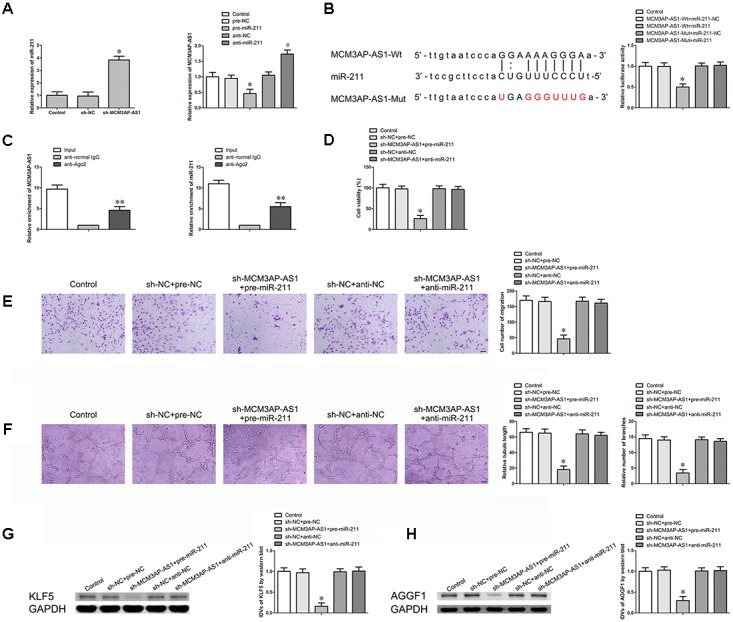
Knockdown of MCM3AP-AS1 inhibited GBM angiogenesis, KLF5 and AGGF1 expression via increasing miR-211 expression. (A) Quantitative real-time PCR analysis for miR-211 expression negatively correlative with MCM3AP-AS1 in GECs. Data are presented as mean ± SD. (n = 5, each group), ∗P < 0.01 vs. sh-NC group, ∗P < 0.01 vs. pre-NC group; #P < 0.01 vs. anti-NC group. (B) The predicted miR-211 binding site in MCM3AP-AS1 and the designed mutant sequences. Dual-luciferase report assay of HEK293T cells co-transfected with MCM3AP-AS1-Wt and miR-211-NC or MCM3AP-AS1-Wt and miR-211, and MCM3AP-AS1-Mut and miR-211-NC or MCM3AP-AS1-Mut and miR-211. Data are presented as mean ± SD. (n = 5, each group), ∗P < 0.05 vs. MCM3AP-AS1-Wt + miR-211-NC group. (C) miR-211 was identified in MCM3AP-AS1-RISC complex. Relative expression levels of MCM3AP-AS1 and miR-211 were determined by quantitative real-time PCR. Data are presented as mean ± SD. (n = 5, each group), ∗∗P < 0.01 vs. anti-normal IgG group. (D) CCK-8 assay was conducted to evaluate the effect of MCM3AP-AS1 and miR-211 on GECs proliferation. (E) Effect of MCM3AP-AS1 and miR-211 on quantification number of GECs migration. (F) Effect of MCM3AP-AS1 and miR-211 on GECs tube formation. Data are presented as mean ± SD. (n = 5, each group). ∗P < 0.05 vs. sh-NC + pre-NC group. (G) The effect of MCM3AP-AS1 and miR-211 on expression of KLF5 by Western blot assay. (H) The effect of MCM3AP-AS1 and miR-211 on expression of AGGF1 by Western blot assay. Data are presented as mean ± SD. (n = 5, each group), ∗P < 0.01 vs. sh-NC + pre-NC group. Scale bars represent 30 μm.